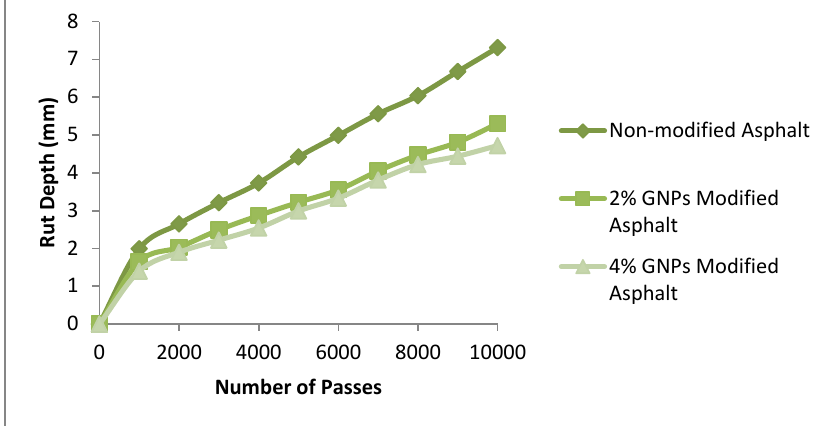
Figure 9. The Wheel Tracking Test results at 55 °C. GNPs = Graphene Nano-Platelets.